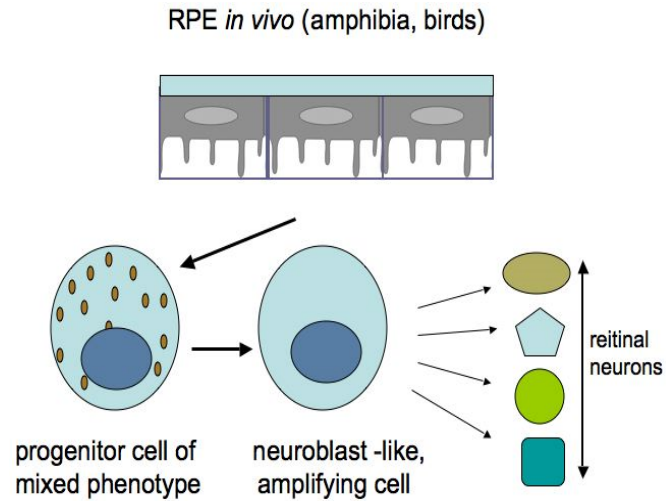
Figure 6. Retinal pigment epithelium cells of adult amphibia and bird embryos are capable of natural reprogramming in vivo. The picture shows the sequence of the main steps in the formation of retinal neurons.